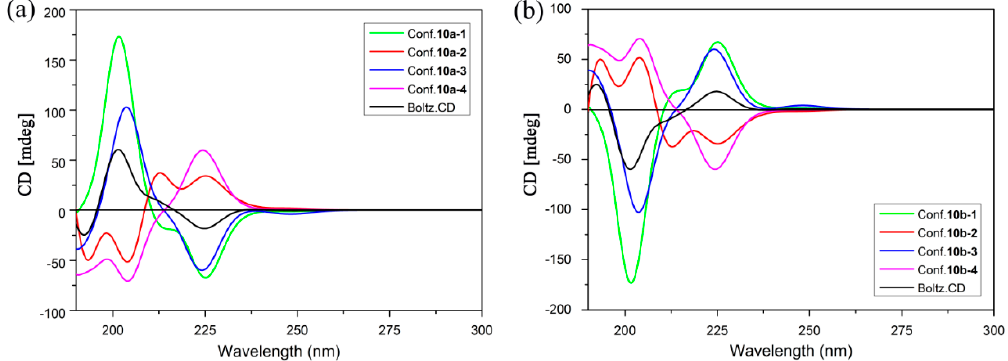
Figure 7. Calculated ECD spectra of individual conformers of ( a ) 10a and ( b ) 10b .